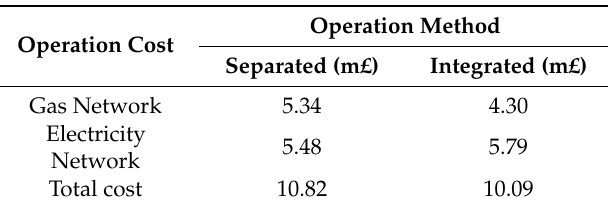
Figure 6. Comparison of network costs in six iterations in separated Method.